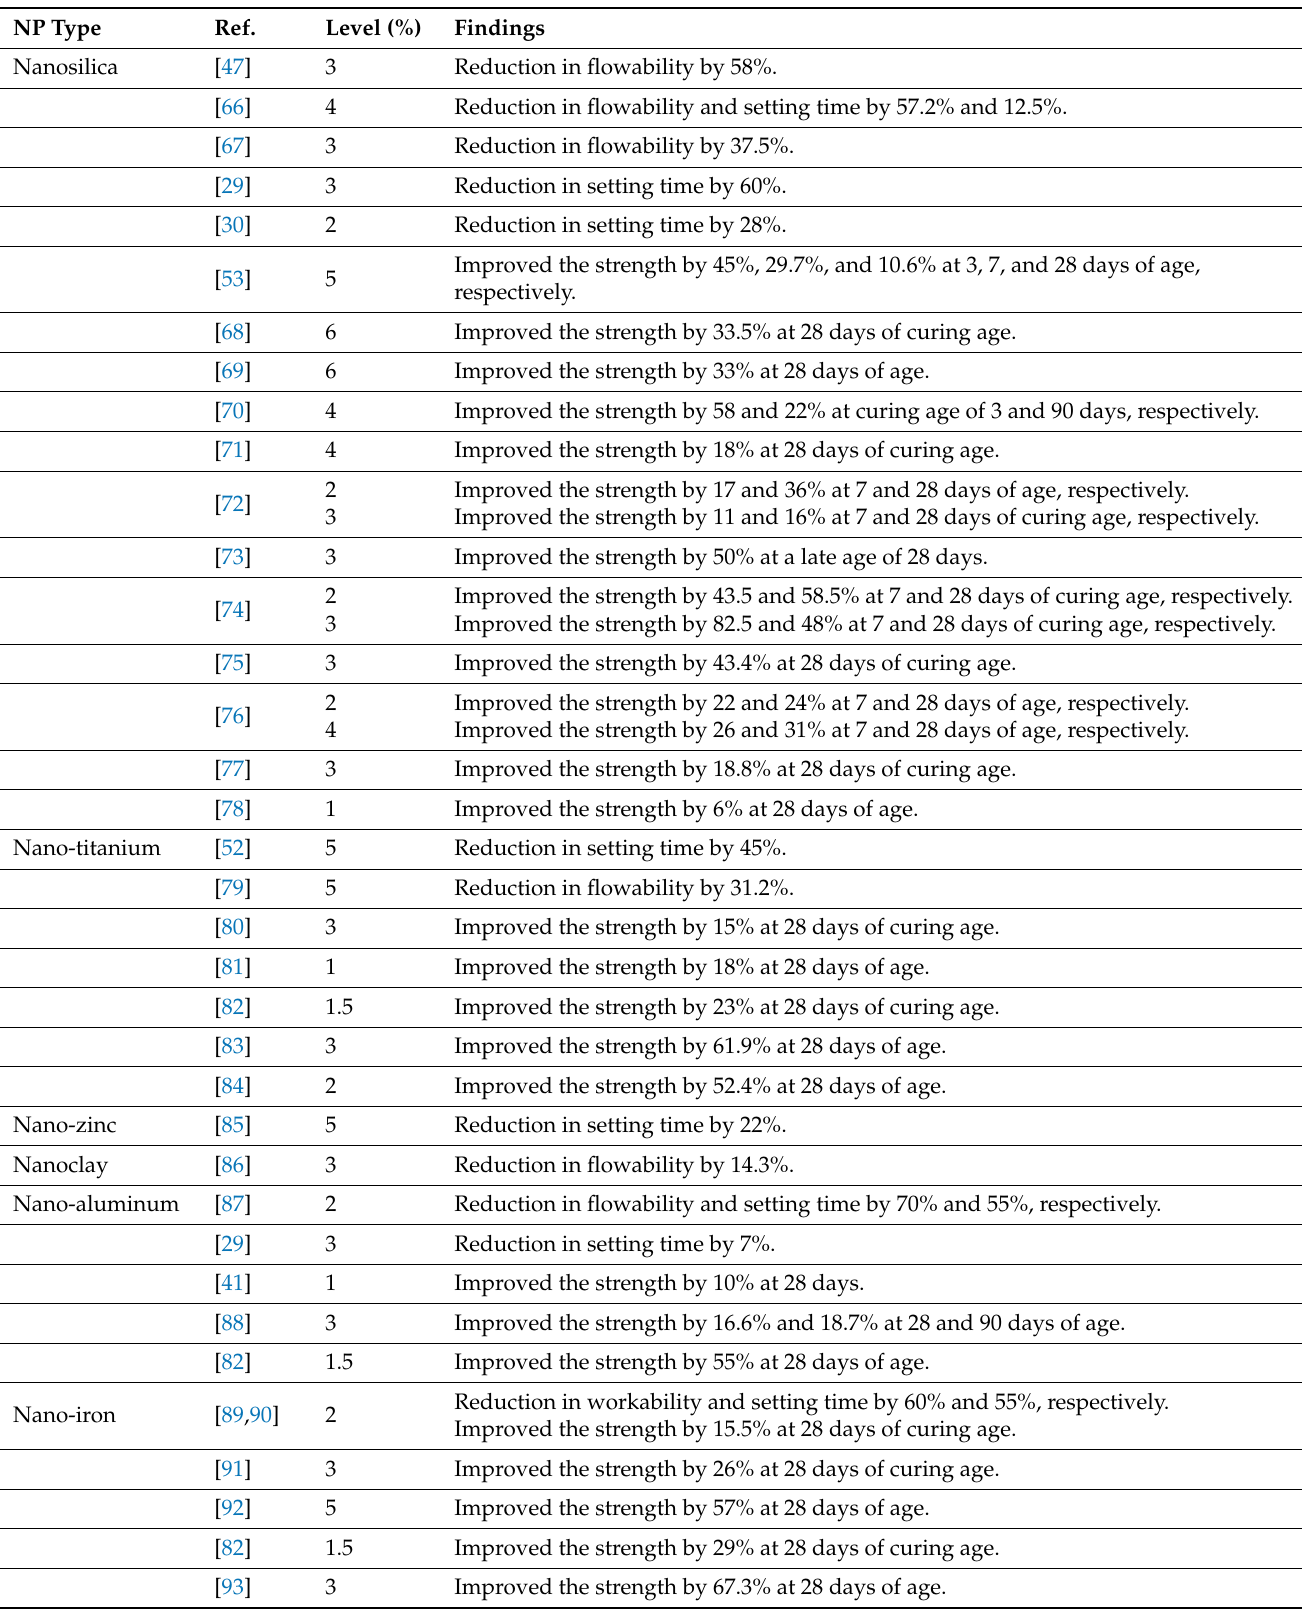
Table 1. Effects of NPs on cementitious fresh, strength, and durability